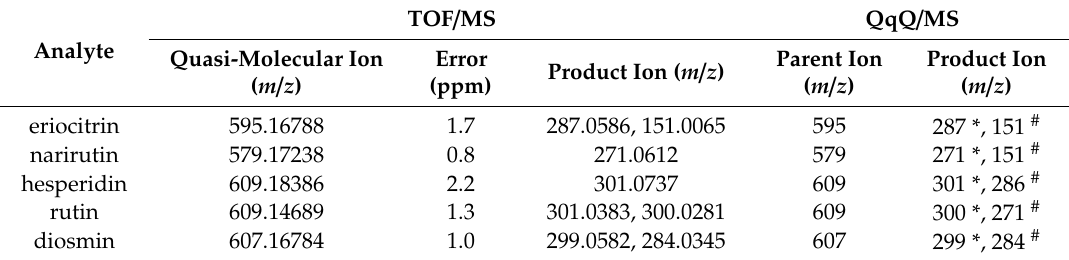
Figure 1. Chemical structures of eriocitrin, narirutin, hesperidin, rutin, and diosmin. Table 1. UPLC-MS parameters of five analytes in the negative ion-scan mode.